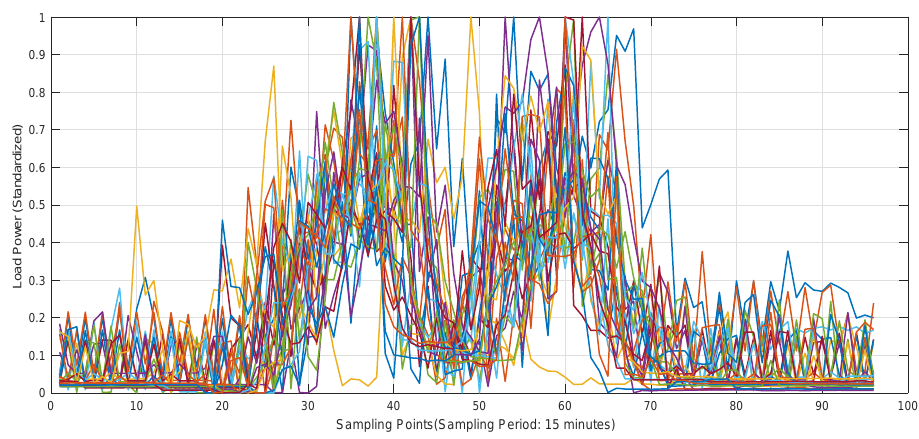
Figure 8. Load curves of 30 customers in Category